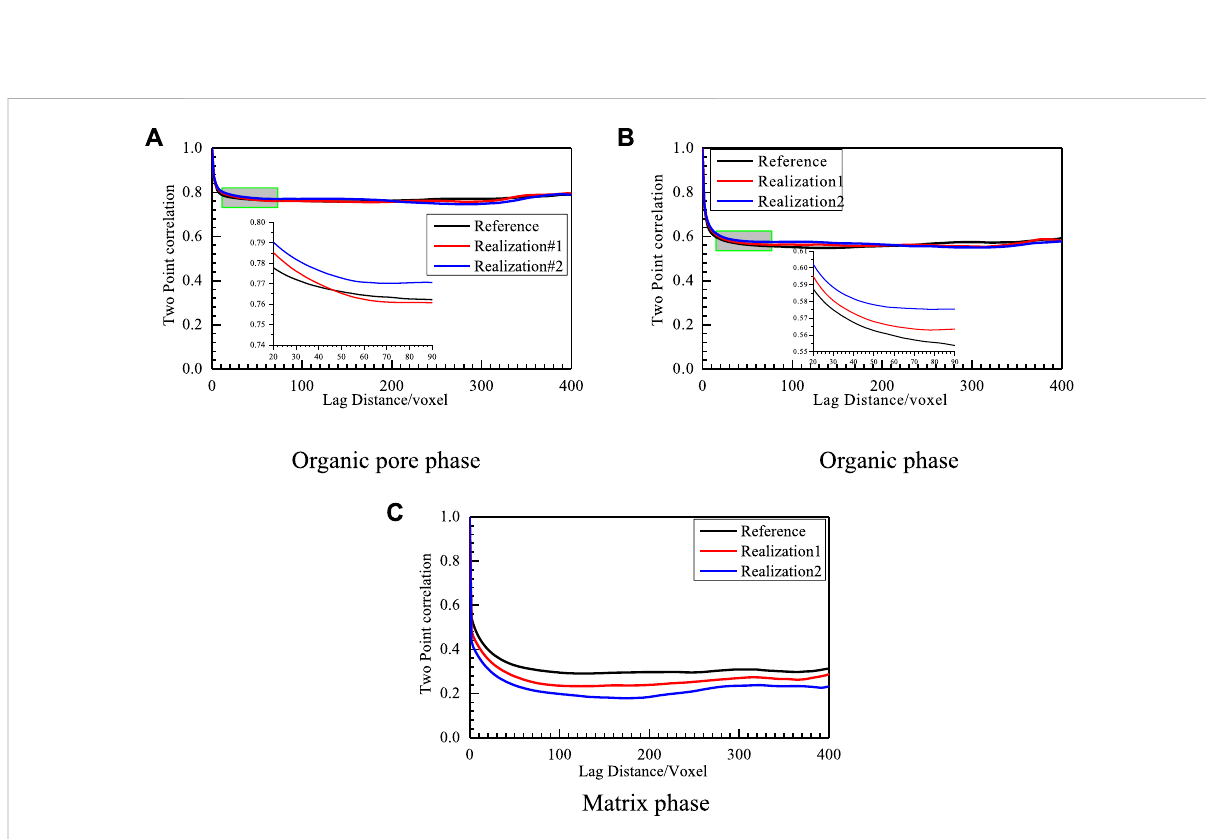
FIGURE 17 Two-point correlation functions of differentphases for the training image and two realizations obtained by segmenting the reconstructed gray images, (A) , (B) , and (C) are comparisons of two-point correlation functions of the reference image and different realizations (realization one and 2) obtained by segmenting the reconstructed gray images for the organic pore, organic matter, and matrix phase, respectively. Black represents the training image, red represents realization one and blue represents realization